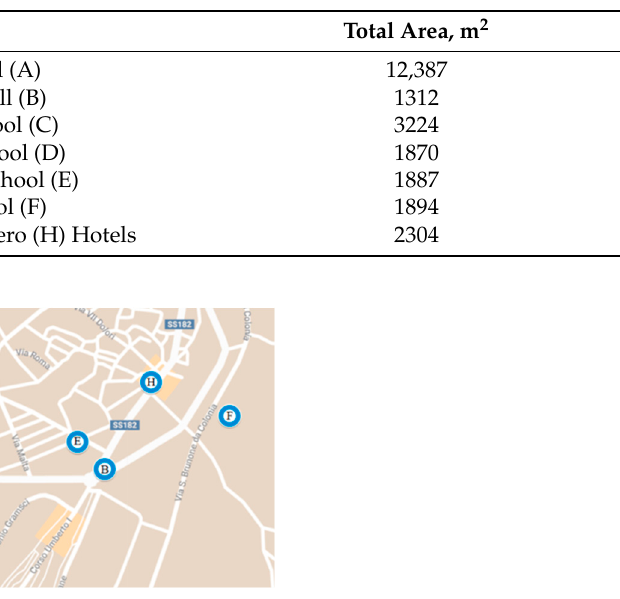
Figure 1. Large users located in Serra San Bruno. (A) San Bruno Hospital, (B) Serra San Bruno Hall, (C) L.Einaudi High School, (D) Secondary Public School, (E) A.Tedeschi Primary School, (F) Serra San Bruno Pool (F), Certosa (G) and Conte Ruggero (H) Hotels.